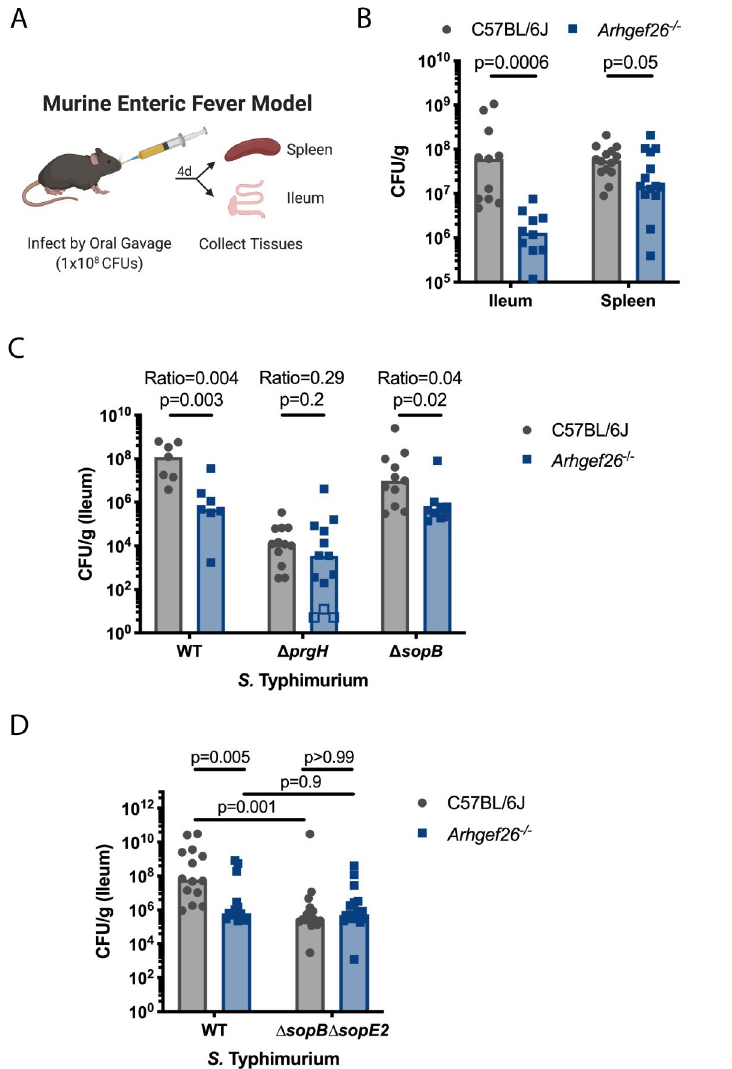
Fig 7. Arhgef26 is critical during S . Typhimurium infection in the enteric fever murine model. (A) Schematic of the murine enteric fever infection model. (B) Arhgef26 -/- mice have reduced ileal and splenic bacterial burden in the enteric fever infection model compared to C57BL/6J mice. P-values generated by Welch’s t-test. (C) Effects of Arhgef26 knockout on bacterial fitness depends on prgH , but not sopB . Open boxes represent mice where no colony forming units (CFU) were recovered from ARHGEF26 -/- mice and the CFU/g was set to the limit of detection. P-values were generated by unpaired t-tests on log transformed values. (D) ARHGEF26 requires SopB and SopE2 to impact ileal burden, and SopB and SopE2 require ARHGEF26. P-values from one-way ANOVA with Sidak’s multiple comparison test on log transformed values. Ratios in C represent median CFU/g recovered from Arhgef26 -/- mice divided by the median CFU/g recovered from C57BL/6J mice. For all experiments, mice were infected with 1x10 8 S . Typhimurium CFU and tissues were harvested four days post infection for CFU quantification. All bar graphs contain data generated from at least two experiments, and each dot represents a single mouse. Data for B and C were normalized to the grand mean prior to plotting or performing statistics. Bars represent the median. All mice were age and sex matched within experiments, with both sexes represented in all